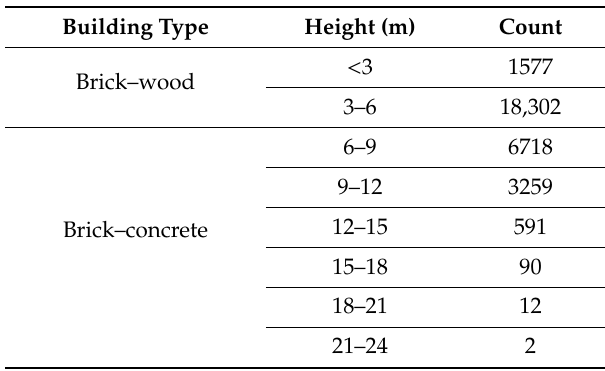
Table 1. Classification and height distribution of buildings.